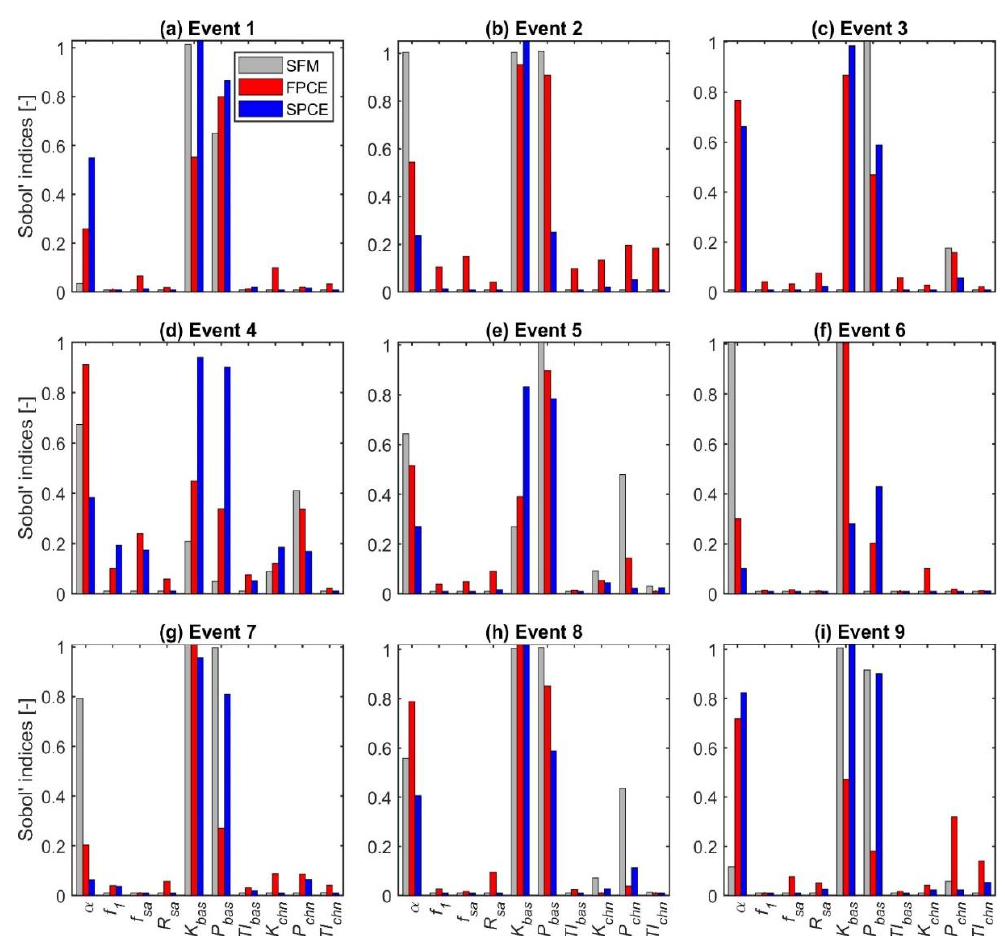
Figure 8. Sobol’ sensitivity analysis for the 10 parameters of SFM (grey), FPCE (red), and SPCE (blue), computed for the objective function of NSE over nine streamflow events.